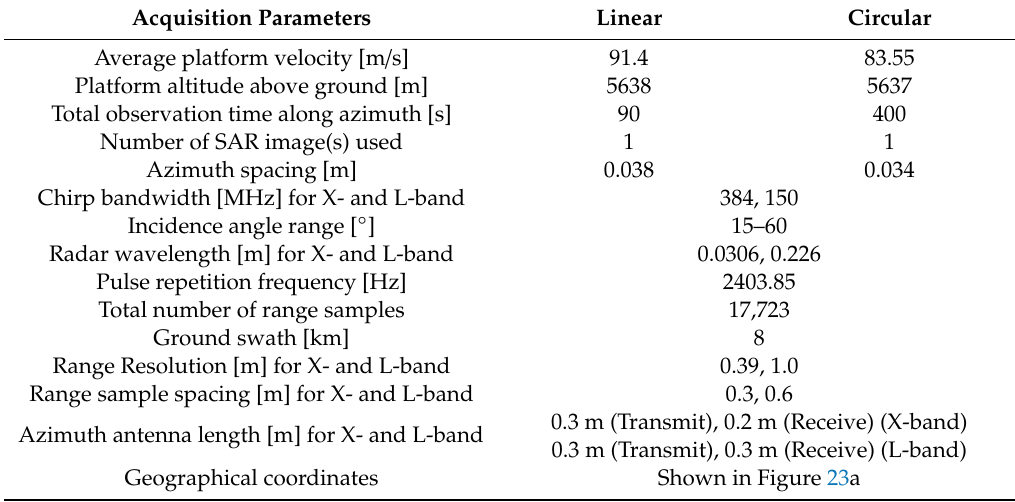
Table 2. Radar system and acquisition geometry parameters for the linear and circular flight.